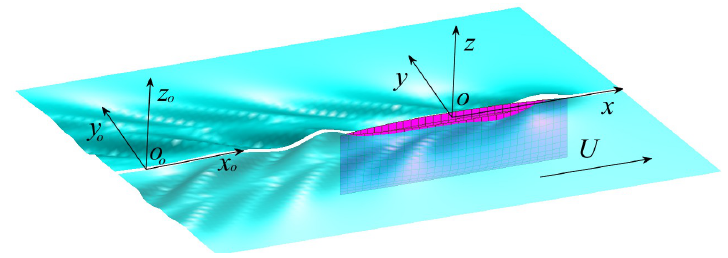
Figure 1. Coordinate systems.